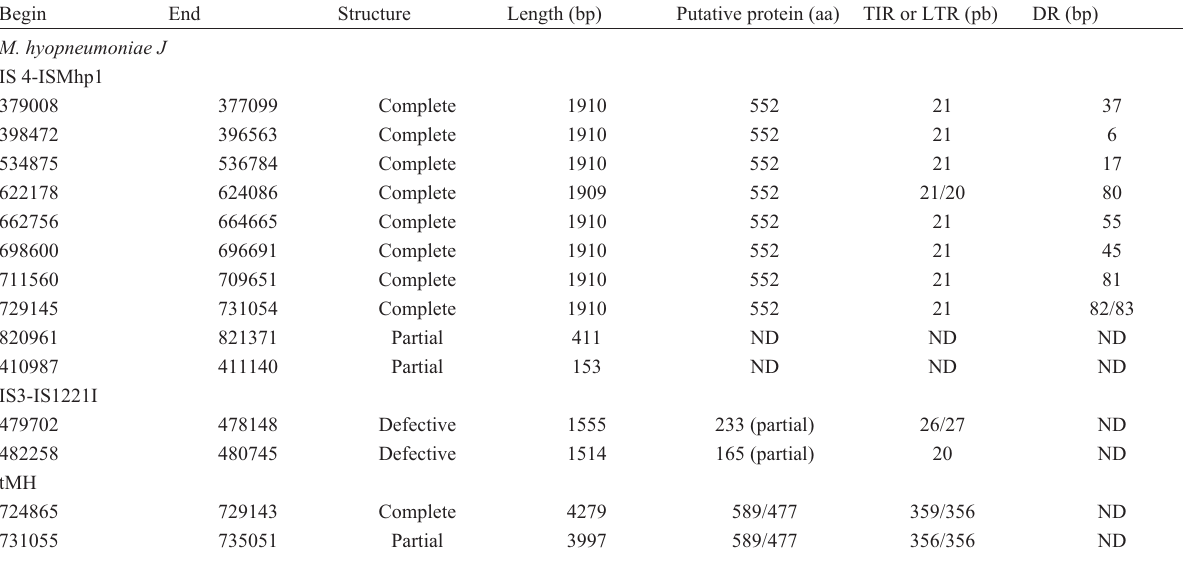
Table 1 - Characterization of IS in the Mycoplasma hyopneumoniae and M. synoviae genomes: location in the genomes (beginning and end), structure (complete, defective or partial), length, the length of putative proteins, TIRs or LTRs and DRs.